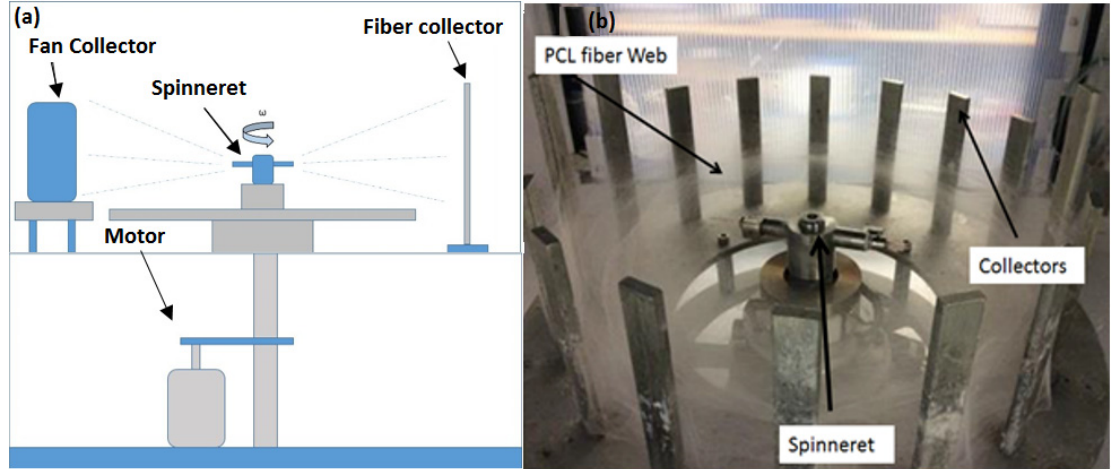
Figure 1. ( a ) Schematic diagram of the FS method and ( b ) digital photo showing the fiber web, spinneret, and collector setup.